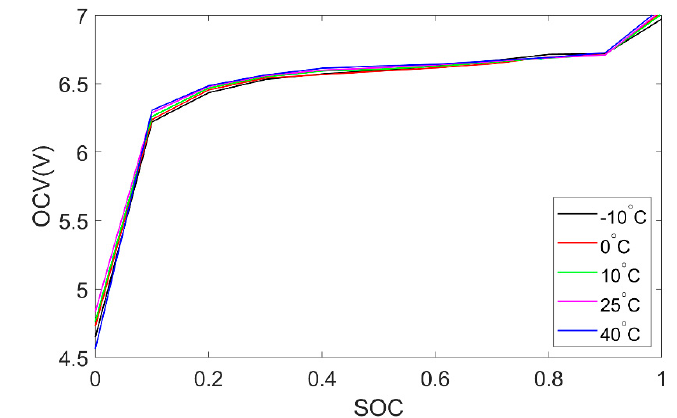
Figure 2. Average open-circuit voltage (OCV) at different temperatures.